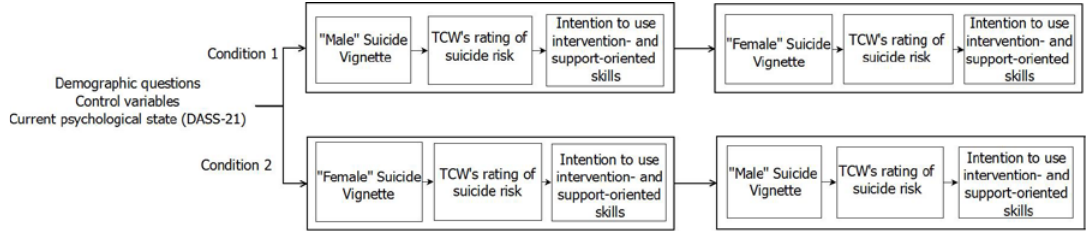
Figure 2. Recruitment flow diagram for pilot and main study.